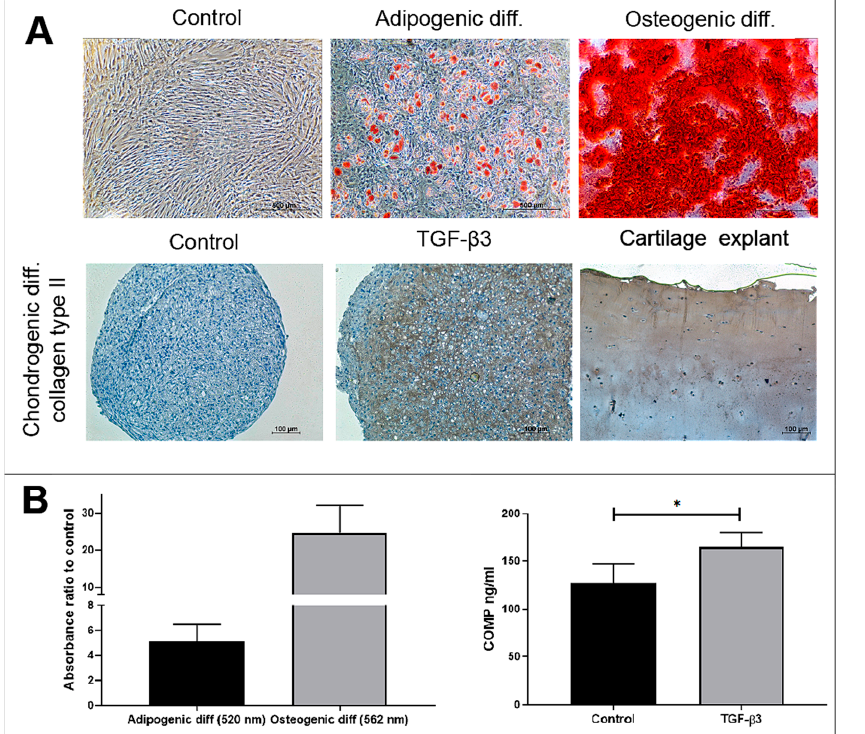
Figure 1. Adipogenic, osteogenic (2D) and chondrogenic (3D) differentiation of BM-MSCs. ( A ) The qualitative evaluation of the adipogenic, osteogenic and chondrogenic differentiation of BM-MSCs by incubating with the appropriate differentiation media for 21 days. The adipogenic differentiation was identified by staining the BM-MSCs with oil red (red lipid droplets), osteogenic—with alizarin red (red calcifications) and chondrogenic—by immunohistochemical labelling with anti-collagen II antibodies (brown) and visualized using a light microscope, by ×40 and ×100. Control chondrogenic pellets were incubated without TGF- β 3. Cartilage tissue is provided as a positive control for collagen type II immunohistochemical labelling. ( B ) The quantitative evaluation of adipogenic and osteogenic differentiations of BM-MSCs (21 days), dissolving lipid droplets in isopropanol and calcium crystals in cetylpyridinium chloride, respectively. Absorbance was measured at 520 nm and 562 nm, respectively. The control cells for the adipogenic and osteogenic differentiation were incubated with a complete DMEM medium and stained with the same dyes. Data are presented as a ratio to control (not differentiated) cells and are shown as mean ± SD from no less than three repeats of three cell cultures. For the quantitative chondrogenic differentiation—the secretion of COMP protein by BM-MSCs pellets with and without TGF- β 3 is provided. Data are presented as mean ± SD and are significant at * p ≤ 0.05 from no less than three repeats of three